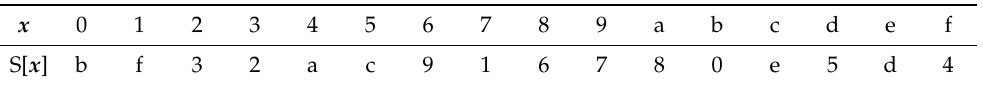
Table 3. Definition of